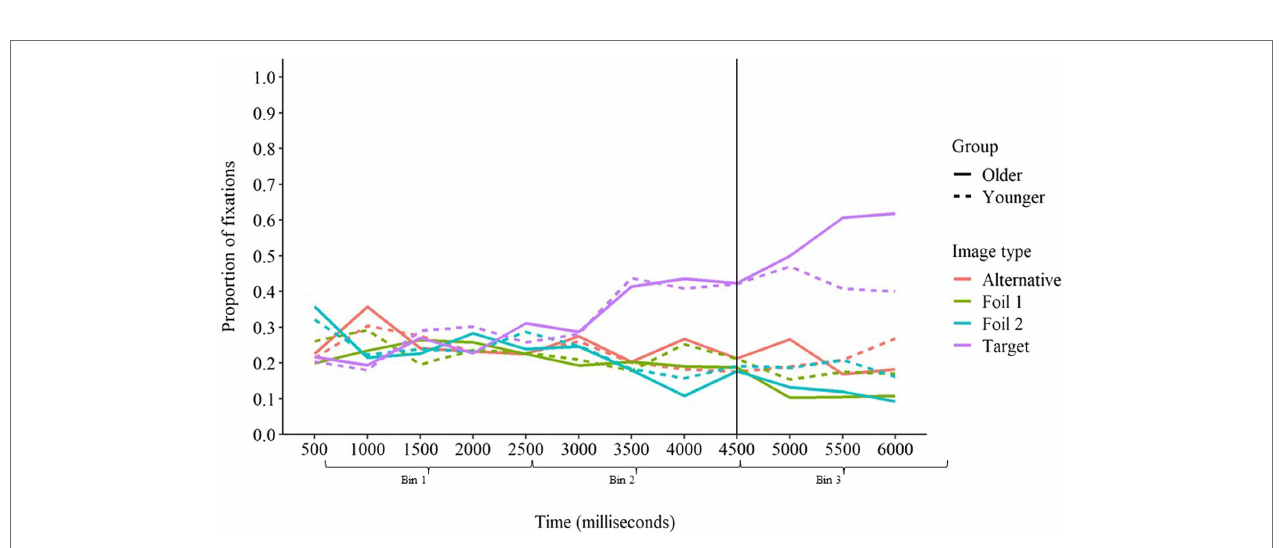
FIGURE 5 | Proportion of fixations on each image type over time in congruent sentences for younger and older adults. The vertical line at 4,500 ms represents the onset of the target